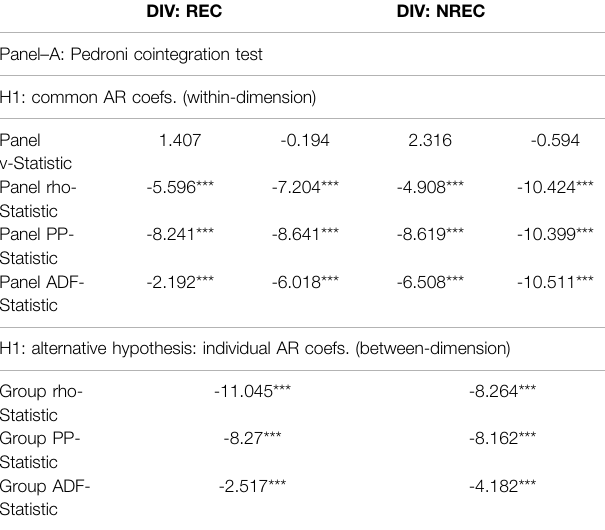
TABLE 4 | Panel cointegration